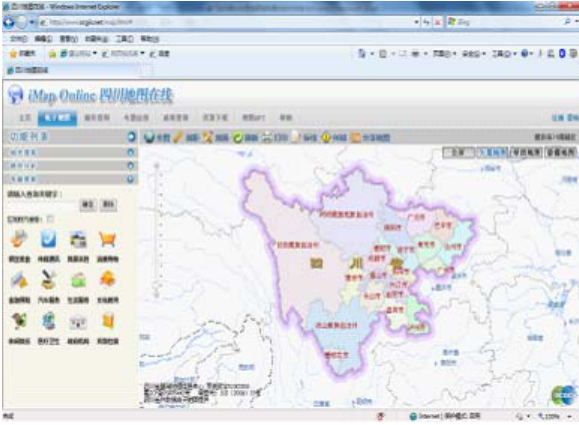
Fig.3. GIS web service of provincial platform aggregating World Map (national